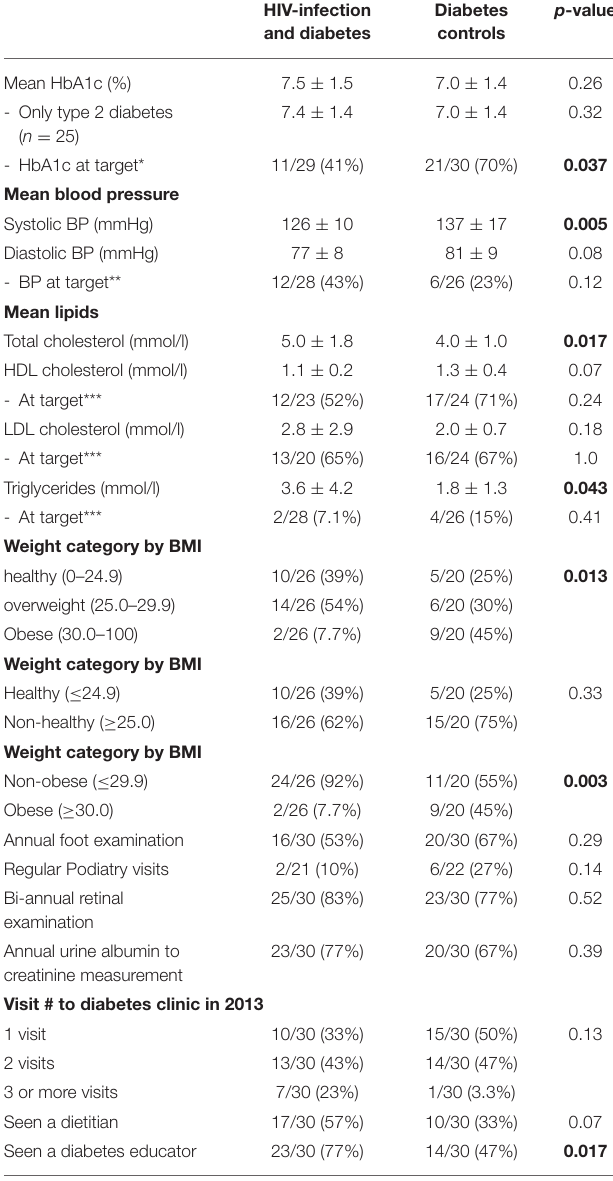
TABLE 2 | HIV-specific characteristics of diabetes clinic attendees with HIV-infection. HIV duration in years ( n = 30)